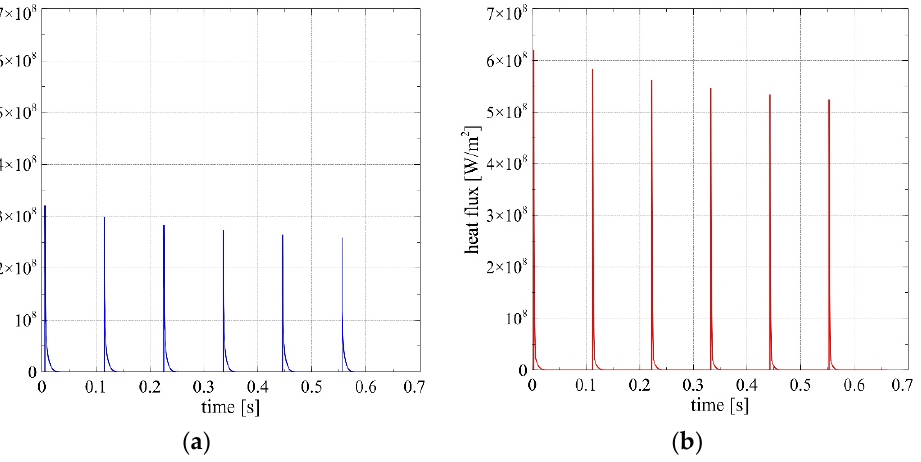
Figure 16. Time courses of the heat flux at the internal barrel surface (( a )—for the validation cross- section of the barrel; ( b )—for the most loaded cross section).